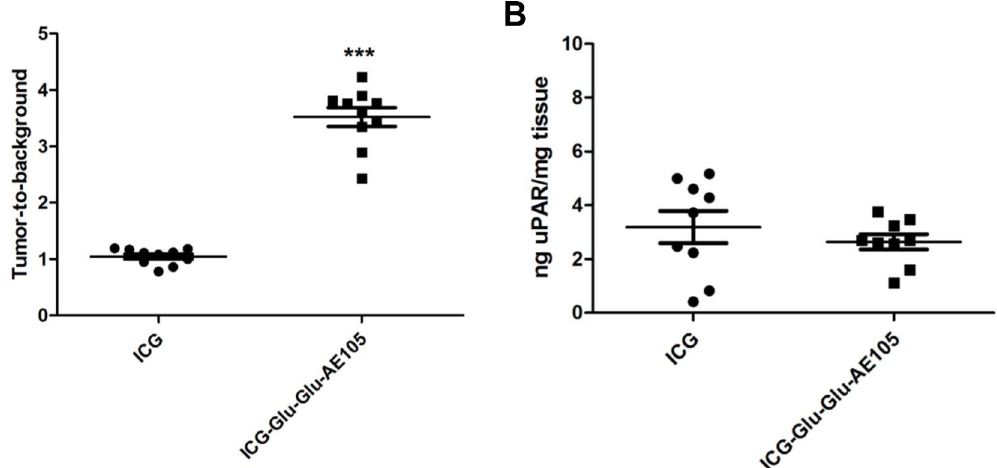
Fig 4. uPAR expression measured by optical signal and ELISA assay. (A) The mean TBR value was significantly different (1.04 ± 0.04 for ICG and 3.52 ± 0.17 for ICG-Glu-Glu-AE105, p < 0.0001), while the uPAR expression per mg tissue was almost identical and supports the hypothesis that the difference in ICG-Glu-Glu-AE105 and ICG signal is due to uPAR binding.